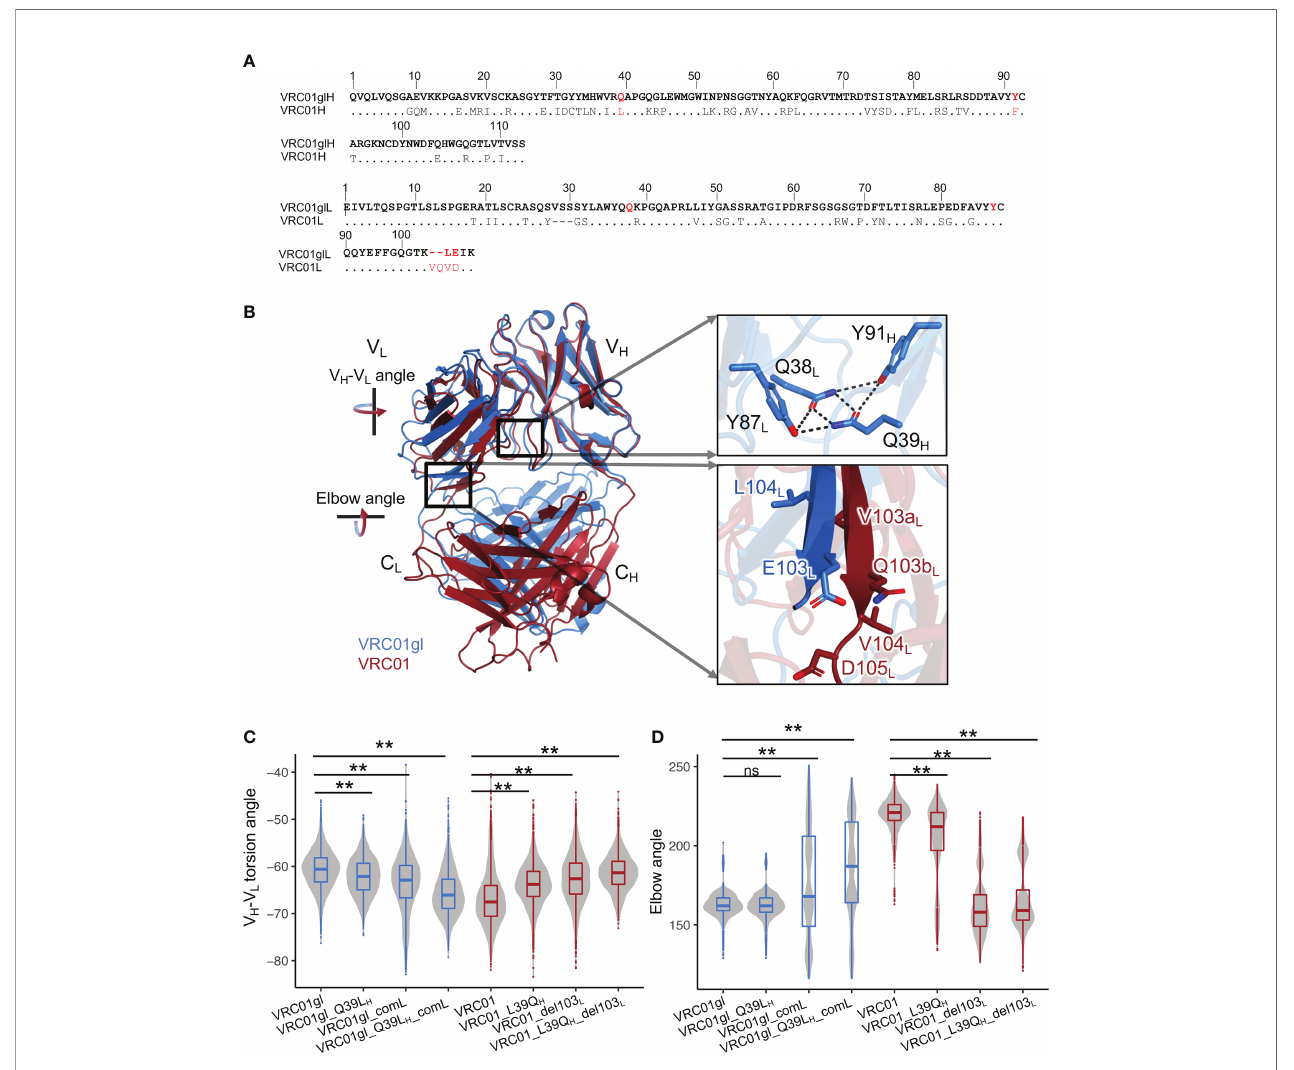
FIGURE 2 | Somatic hypermutations involving Q39L H and FWR4 L insertion modulate V H -V L and elbow angles. (A) Heavy and light chain sequence alignments of VRC01gl and VRC01. VRC01 residues identical to VRC01gl are shown in dots. (B) Superimposition of structures of VRC01gl and VRC01 using heavy chain variable domain shows that V H -V L and elbow conformation are changed in mature VRC01. (C) V H -V L angle distribution of VRC01gl and VRC01 mutants from MD simulation. Other parameters for measuring the V H -V L conformation are shown in Figure S2C . (D) Elbow angle distribution of VRC01gl and VRC01 mutants from MD simulation. Kolmogorov – Smirnov test is used to compare the signi fi cance of difference for V H -V L and elbow angles. P values less than 0.01 are labeled with two stars. We use Bonferroni Correction to control false discover rate of multiple test <0.01. ns, not signi fi